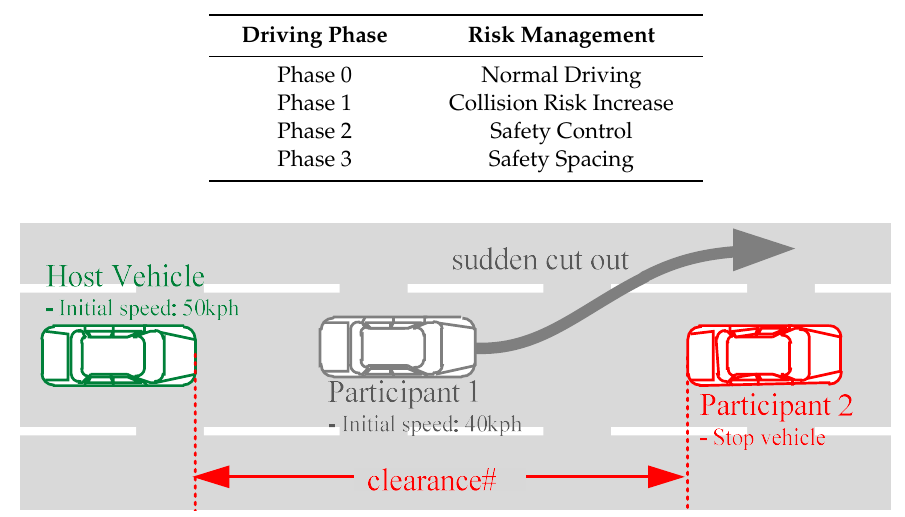
Figure 4. Test scenario: Sudden stop due to unexpected stop-vehicle.